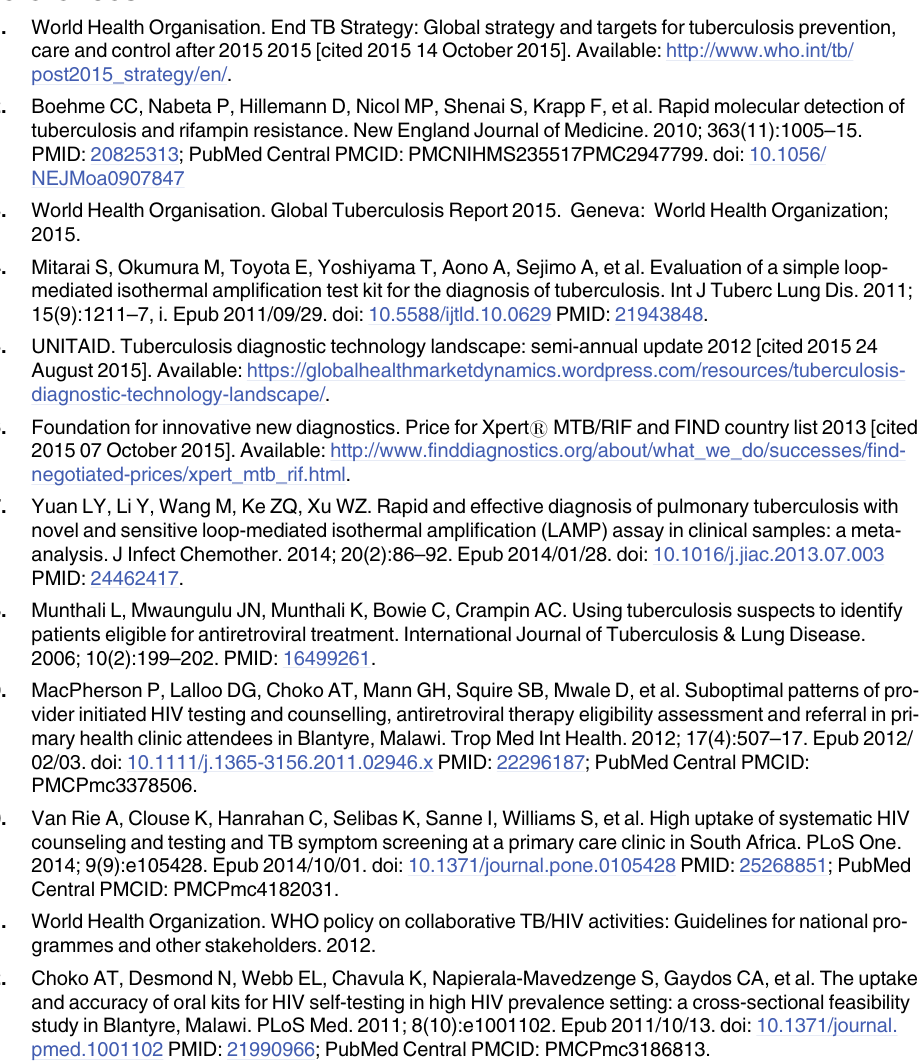
S2 Table. Additional measures of diagnostic accuracy